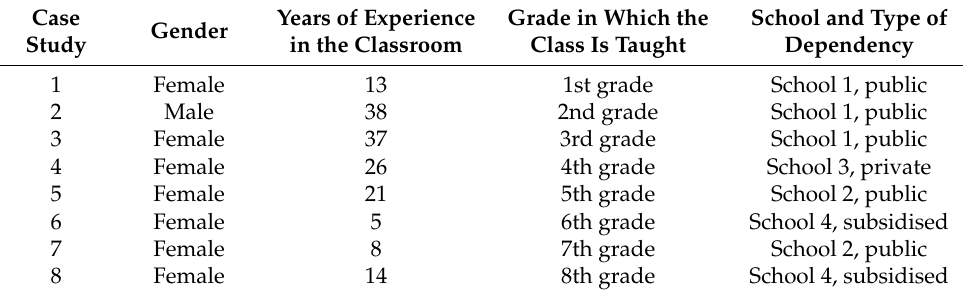
Table 1. Characterisation of the case